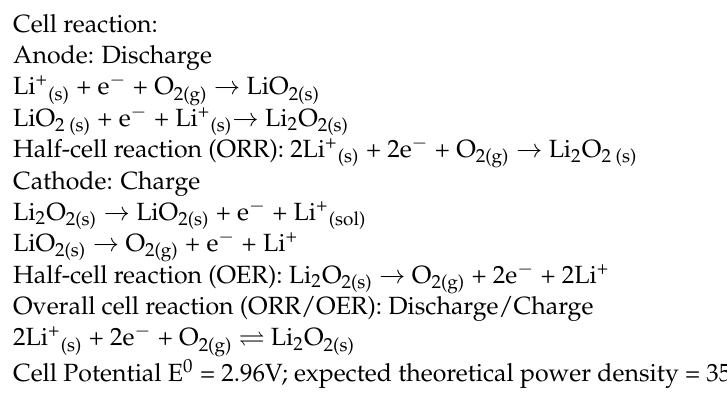
Figure 2. ( A ) Schematic representation of non-aqueous Li-O 2 battery, ( B ) The first discharge/charge curve. Reprinted/adapted with permission from Ref. [20]. Copyright 2017, copyright Wiley-VCH.